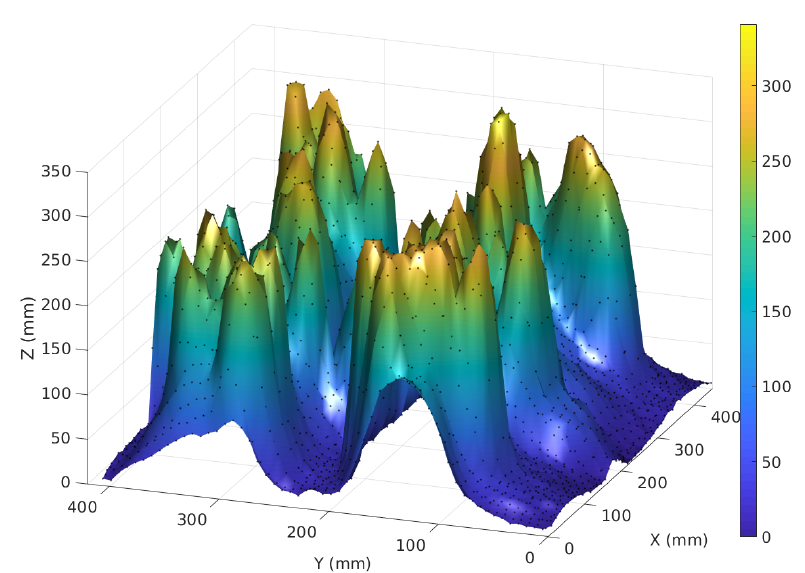
Figure 6. Wheat stubble mock-up 3D representation.